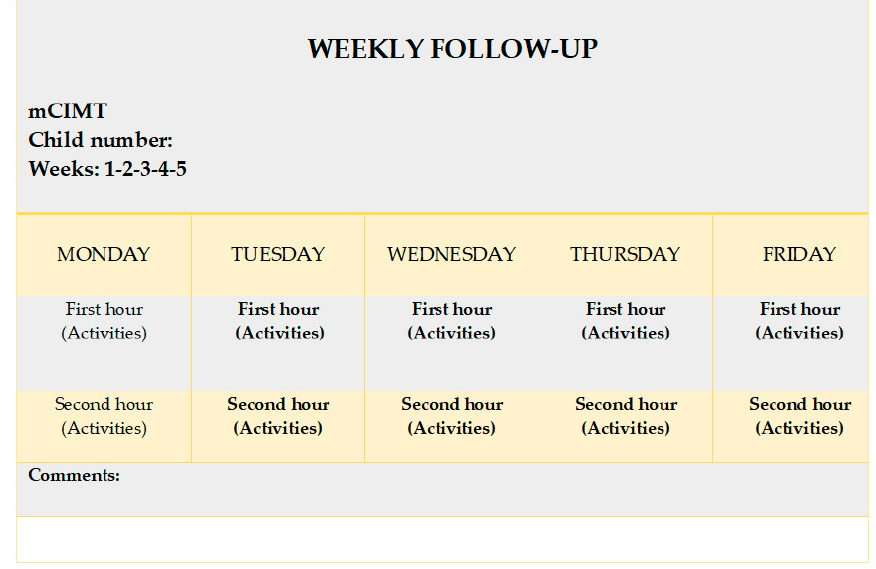
Figure 2. Weekly follow-up for the families.